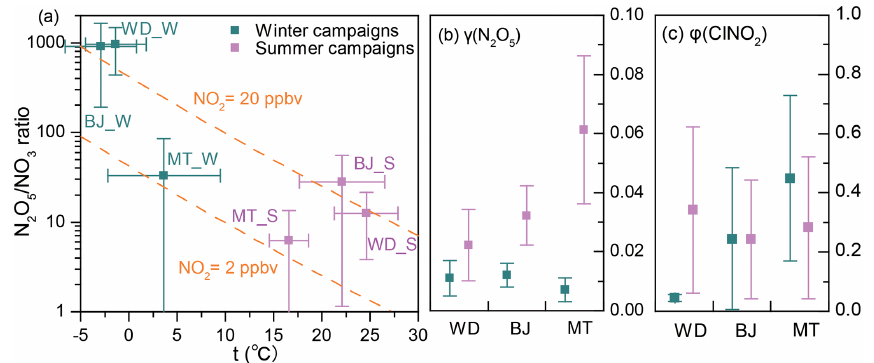
Figure 6. Comparison of the (a) N 2 O 5 / NO 3 ratio, (b) γ (N 2 O 5 ), and (c) ϕ (ClNO 2 ) during the winter and summer campaigns. Square dots and error bars indicate the average values and standard deviations,